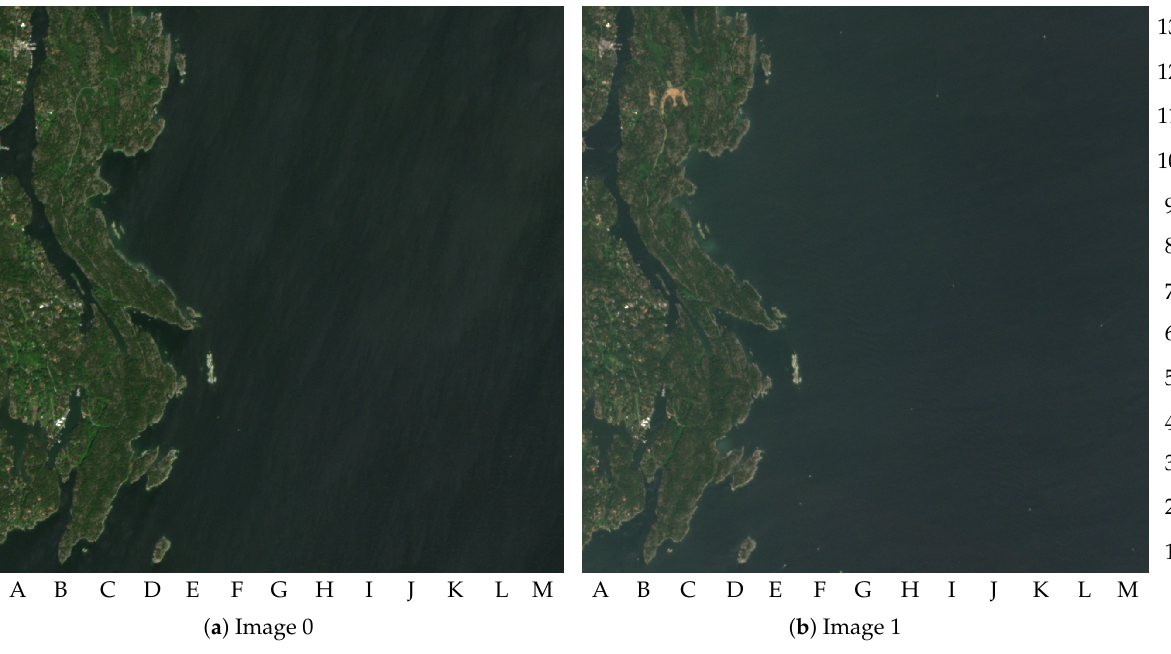
Figure 6. Images samples, RGB bands (truncated at 2000): ( a ) image 0; ( b ) image